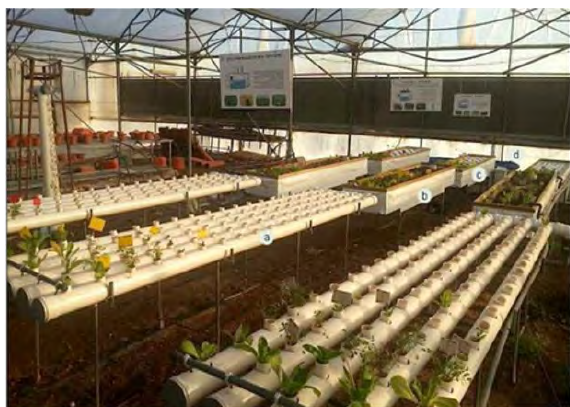
Figure 8. Combined aquaponic unit for educational purposes. (a) nutrient film technique; (b) media bed; (c) deepwater culture; (d) fish tank (Food and Agriculture Organization of the United Nations Rome,